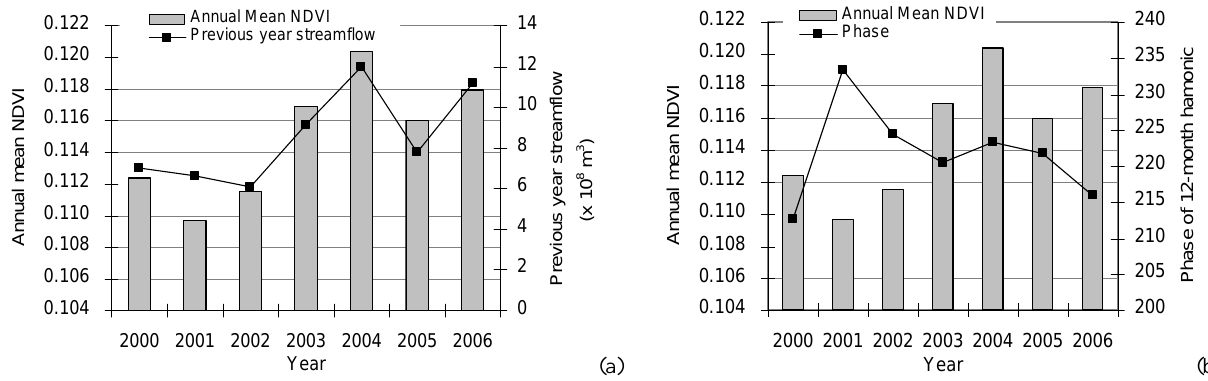
Fig. 7. Area-averaged annual mean NDVI and the previous year total river streamflow (a) and the phase value of 12-month Fourier harmonic component (b) between 2000 and 2006 in the Ejina Oasis of the Heihe River’s lower reach. The phase value indicates the time of peak green-up of the vegetation.